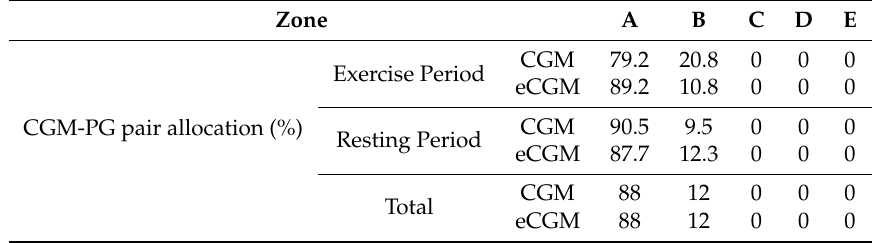
Table 6. Table of results for the classification of the CGM samples in the different Parkes EGA